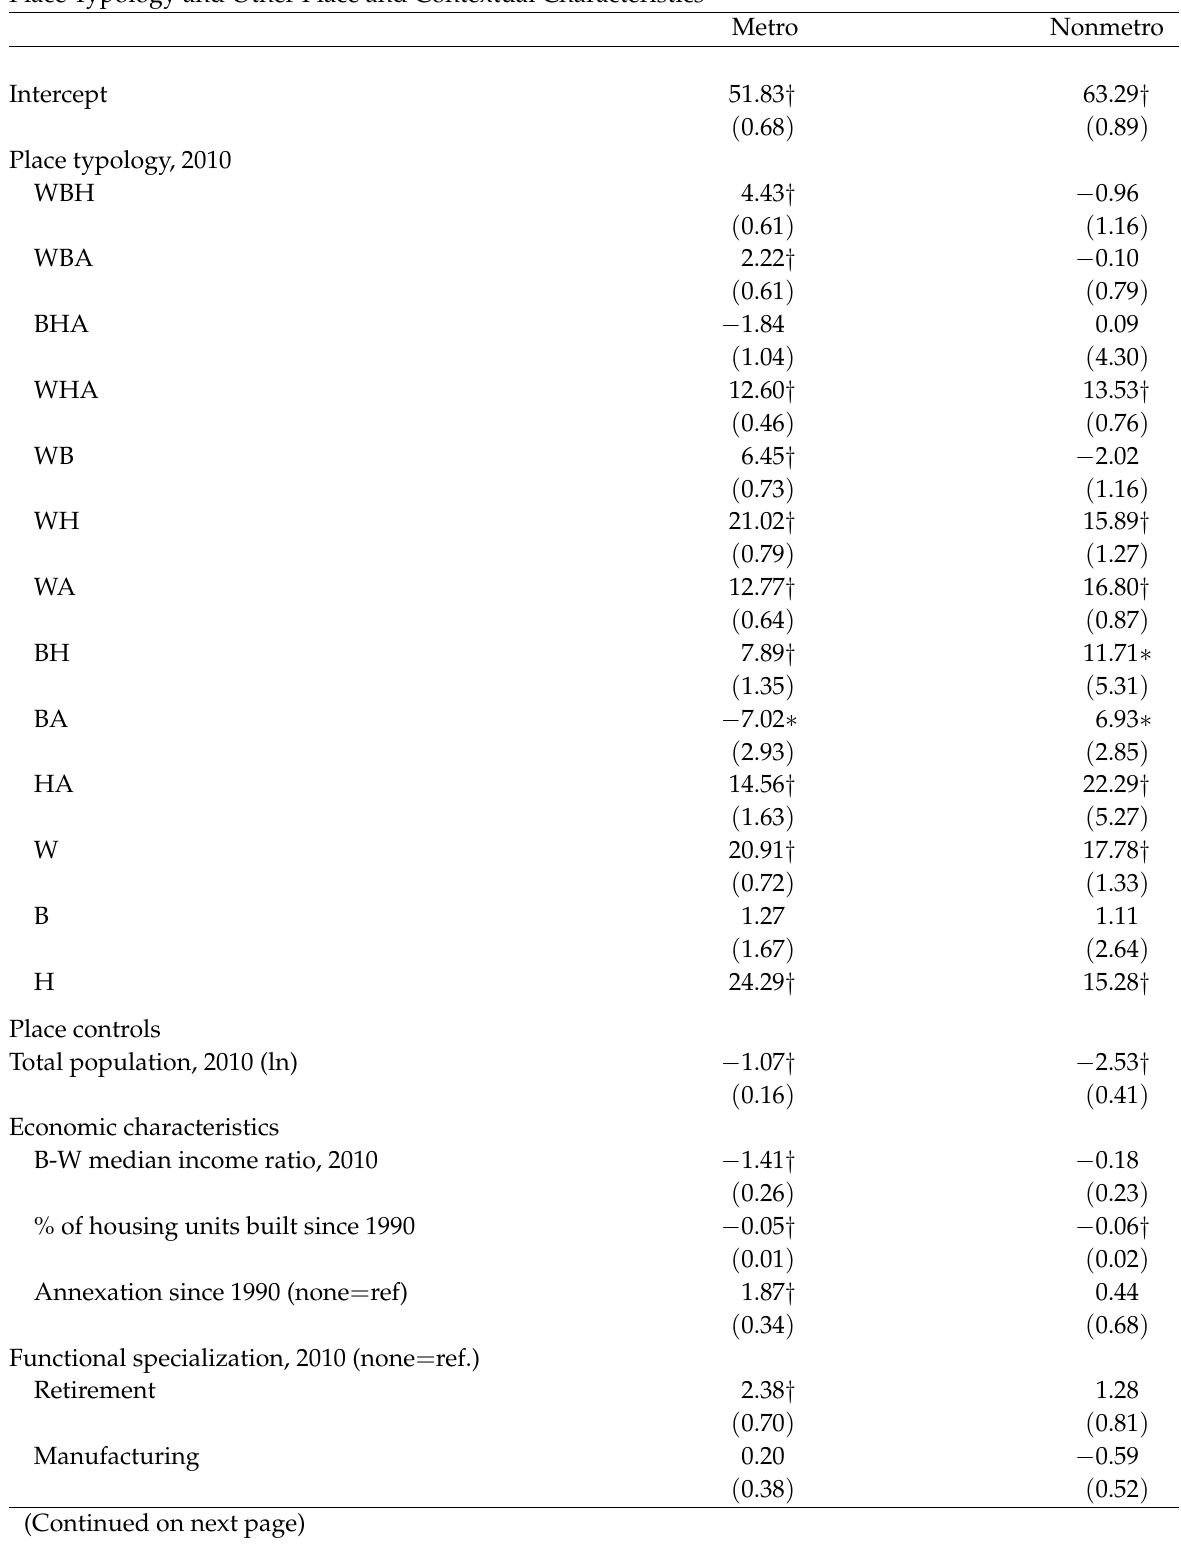
Table 5: Fixed and Random Effects from HLM Regressions of 2010 Black-White Residential Segregation on Place Typology and Other Place and Contextual